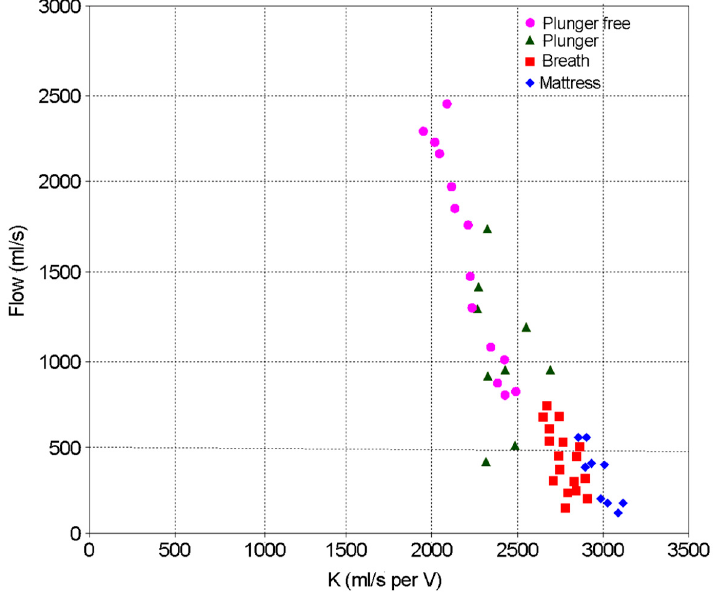
Figure 12. Summary of the measured flow rate (mL/s) as a function of calibration constant, K (mL/s per volt), for a number of different sources of air flow.